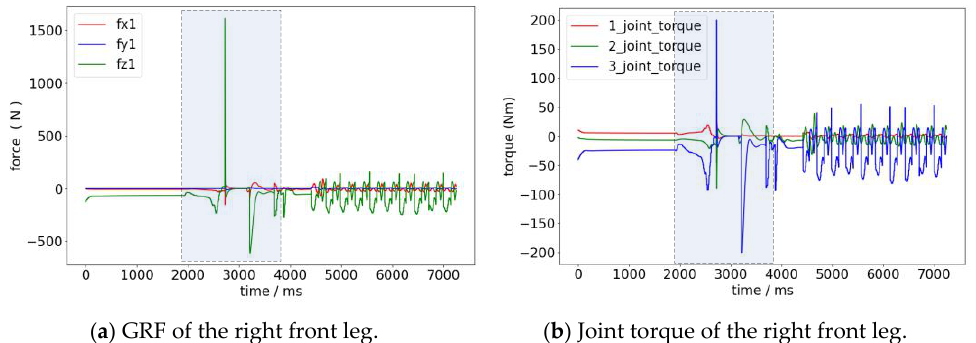
( a ) GRF of the right front leg. ( b ) Joint torque of the right front leg.